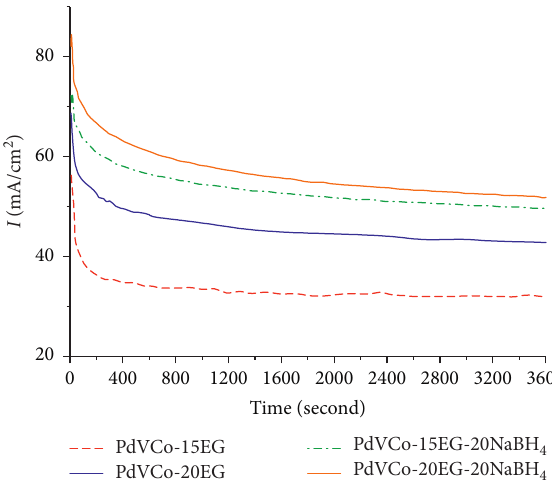
Figure 7: CA curves of nanocatalysts PdVCo recorded at − 0.130V in a solution of 1 M KOH+1 M CH 3 OH.